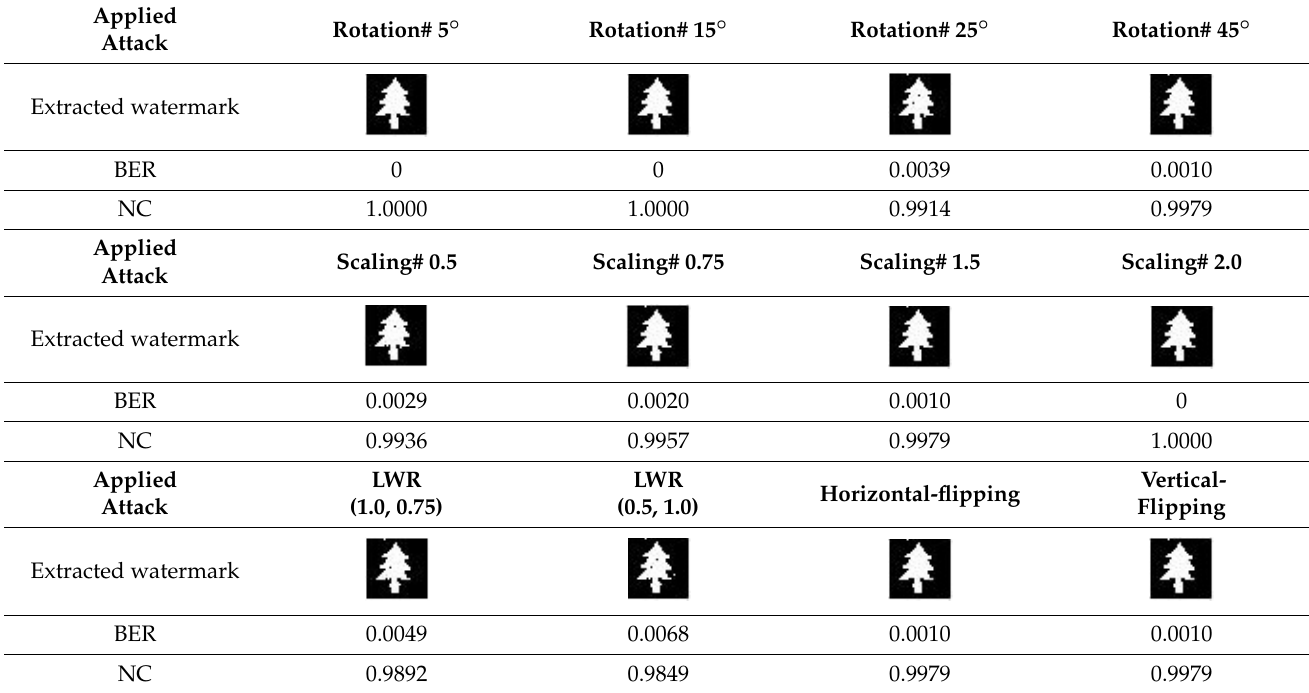
Table 4. The watermarks and corresponding BER and NC values were extracted under common geometric attacks.